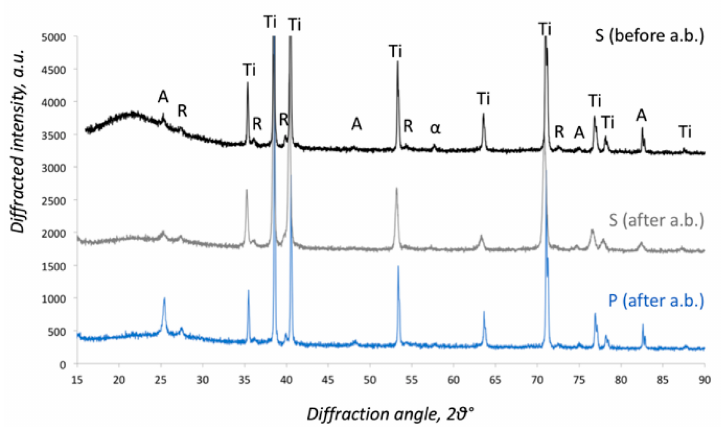
Figure 2. Indexed XRD patterns (Cu K α radiation) characteristic of the through-thickness composition of PEO single layers obtained in DC mode from silicate- or phosphate-based baths (a.b.: abrasive blasting). Ti: Ti-6Al-4V; A: anatase (TiO 2 ); R: rutile; α : α -Al 2 O 3